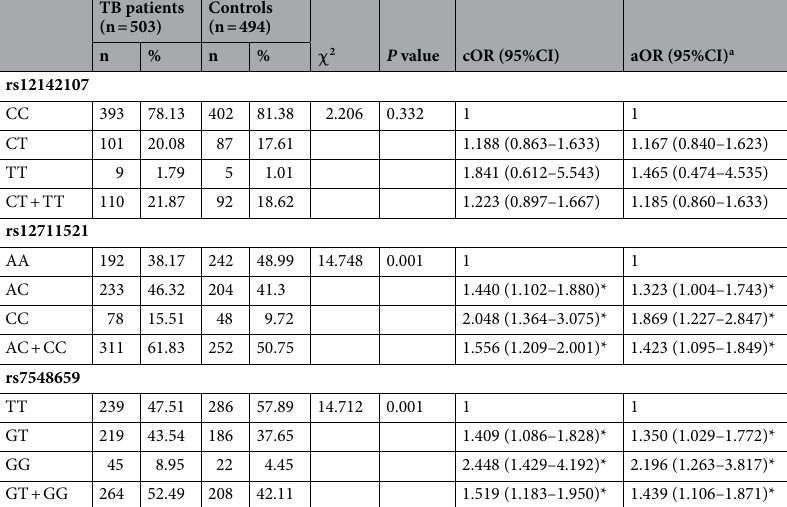
Table 1. MASP2 gene polymorphism versus TB incidence. For Hardy–Weinberg equilibrium detection, P > 0.05. *P < 0.05. a A multivariate logistic regression model was used to adjust the covariates of sex, age, marital status, educational background, BMI, smoking status, alcohol drinking, tea drinking, and BCG vaccination.